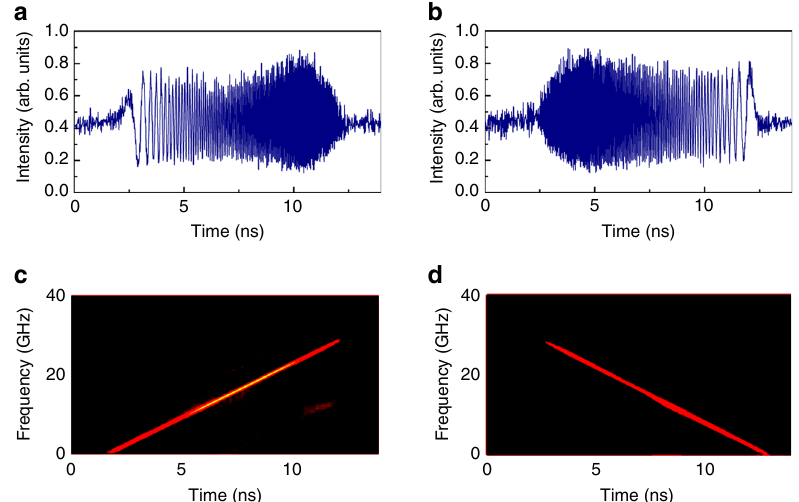
¼ (cid:2) 77 : 353 MHz ( a , c ) and f ¼ (cid:2) 77 : 303 MHz ( b , d ). a , b Temporal traces s s